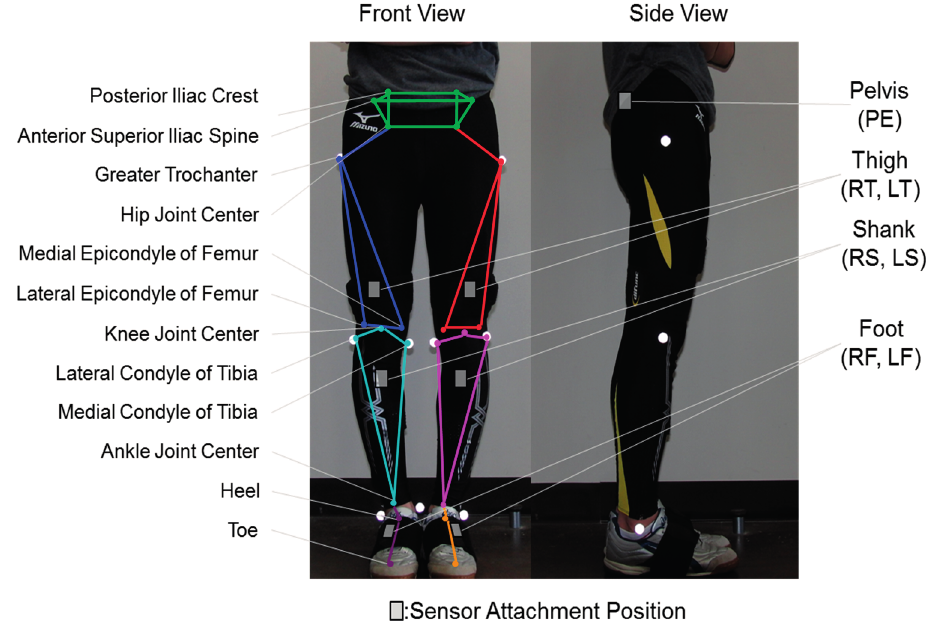
Figure 1. Sensor attachment location and gait wire frame model. The wire frame model is created by connecting characteristic positions of the lower limb. Sensor units are attached to seven body segments of the lower limb. This model has been implemented from the works of Tadano et al.